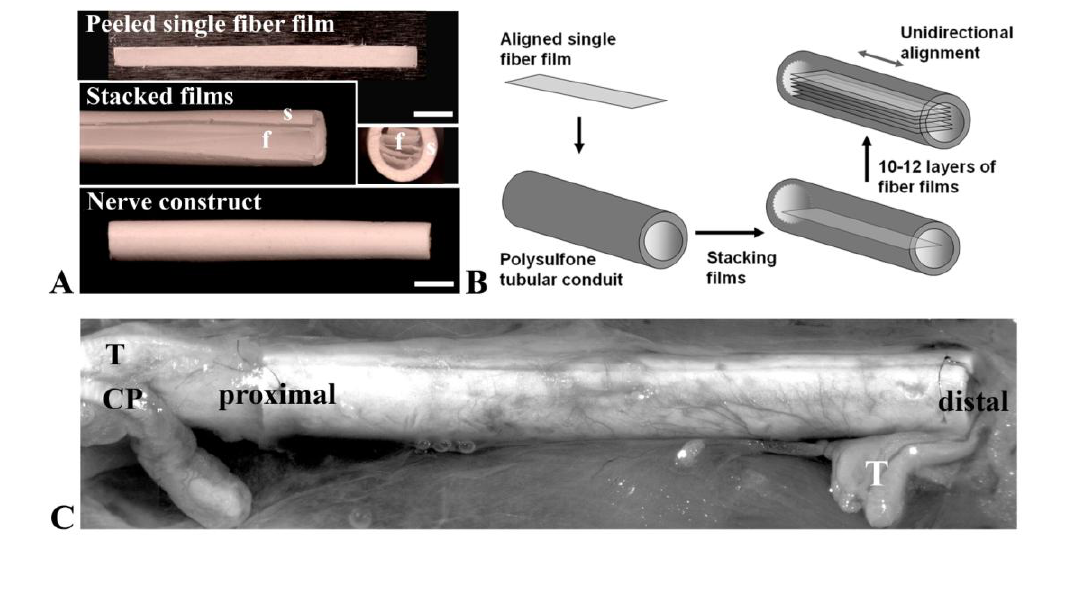
Figure 5. Representative photograph of the polysulfone nerve conduit (Koch Membrane Systems). ( A ) Either aligned or random fiber films were stacked within a nerve conduit. Abbreviation: f = fiber film and s = polysulfone nerve conduit. Scale bar = 2 mm. ( B ) Schematic of polymeric construct fabrication procedure. ( C ) shows explanted aligned construct. Abbreviation: T = tibial nerve and CP = common peroneal nerve